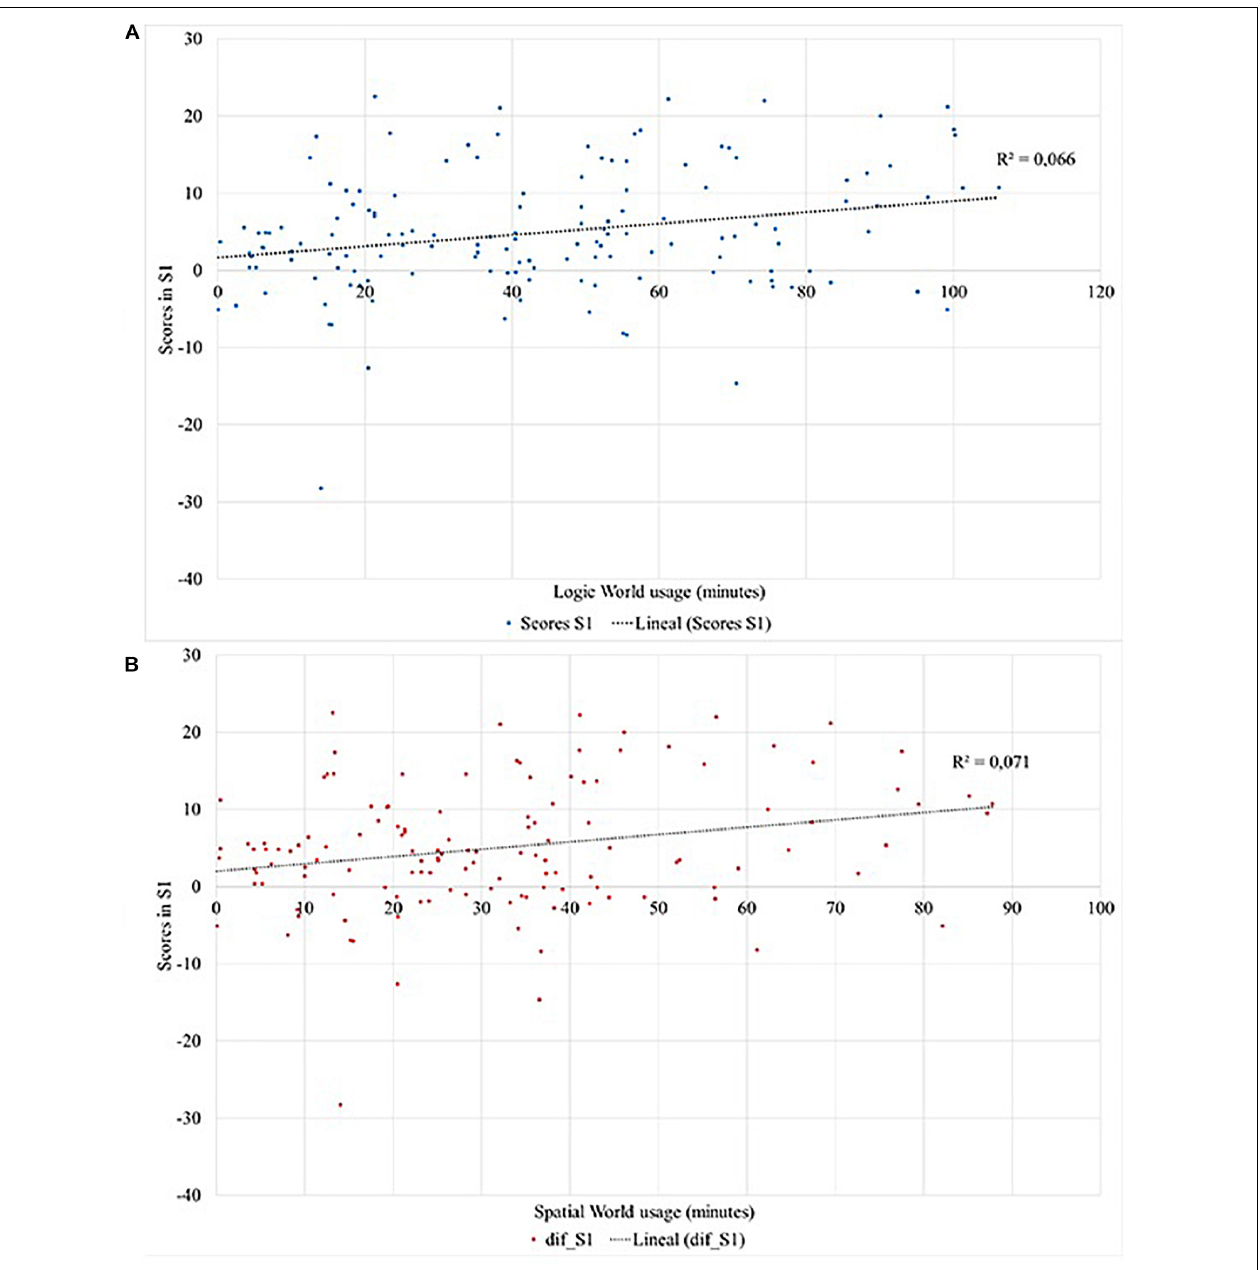
FIGURE 5 | (A) Graphic of regression analysis with the usage of Logic world and its relation with scores from S1. (B) Graphic of regression analysis with the usage of Spatial world and its relation with scores from S1.